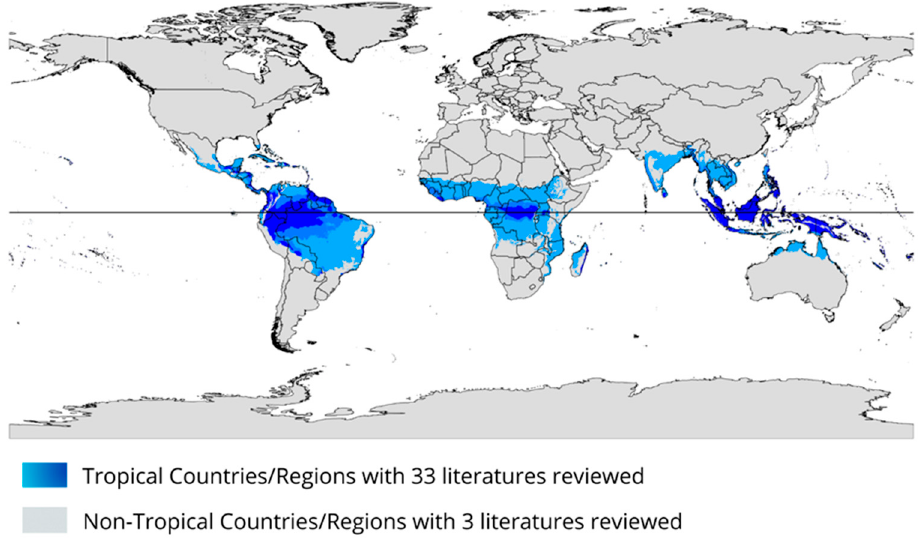
Figure 5. Number of literature studies reviewed for the Tropical and Non-Tropical Regions, with figure adapted from Beck et al. (2018). [38]. https://creativecommons.org/publicdomain/zero/1.0/, accessed on 20 July 2022.